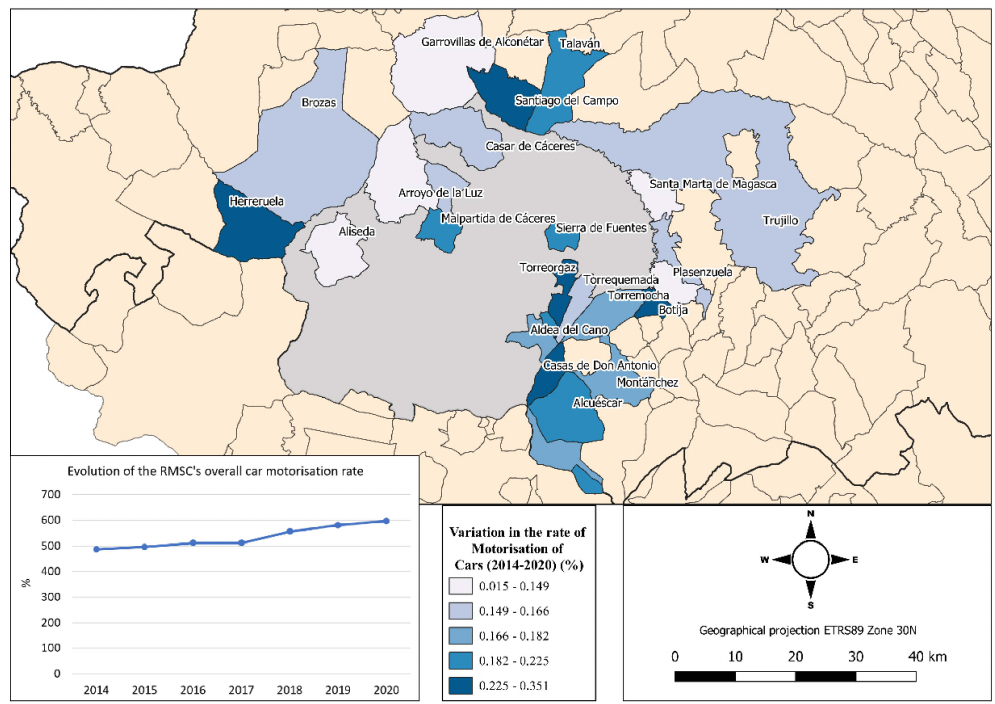
Figure 5. Motorisation of passenger cars in the RMSC (2014 –